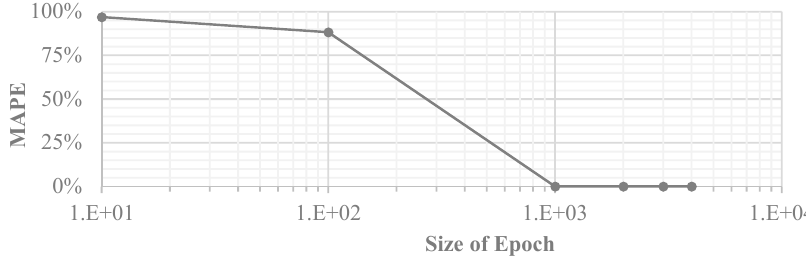
Figure 8. Selection of the epoch size for the DNN model.